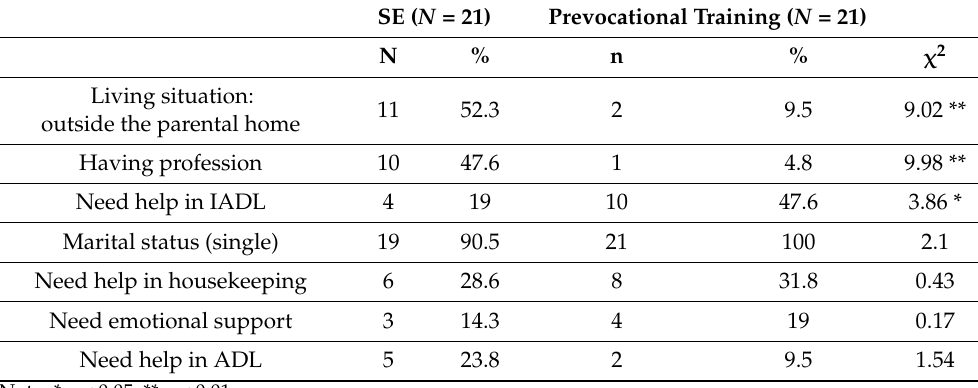
Table 2. Comparing sample characteristics between the two groups (categorical